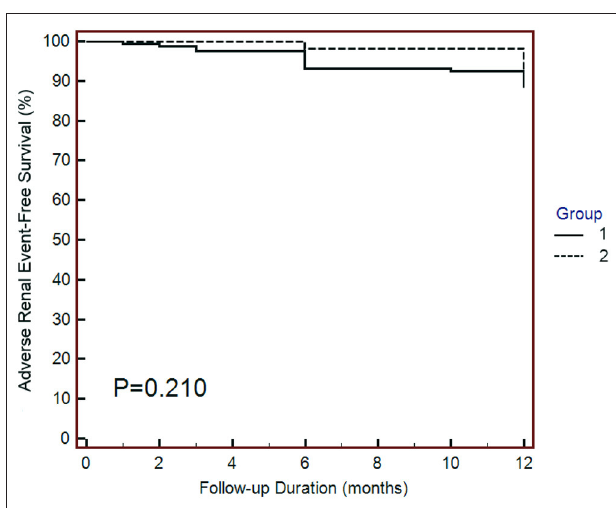
FIGURE 2 | Kaplan–Meier curves of adverse cardiovascular outcomes. Adverse cardiovascular outcomes were defined as the composite of rehospitalization due to acute coronary syndrome or sudden cardiac death. Statistical analysis was performed using the log-rank test.